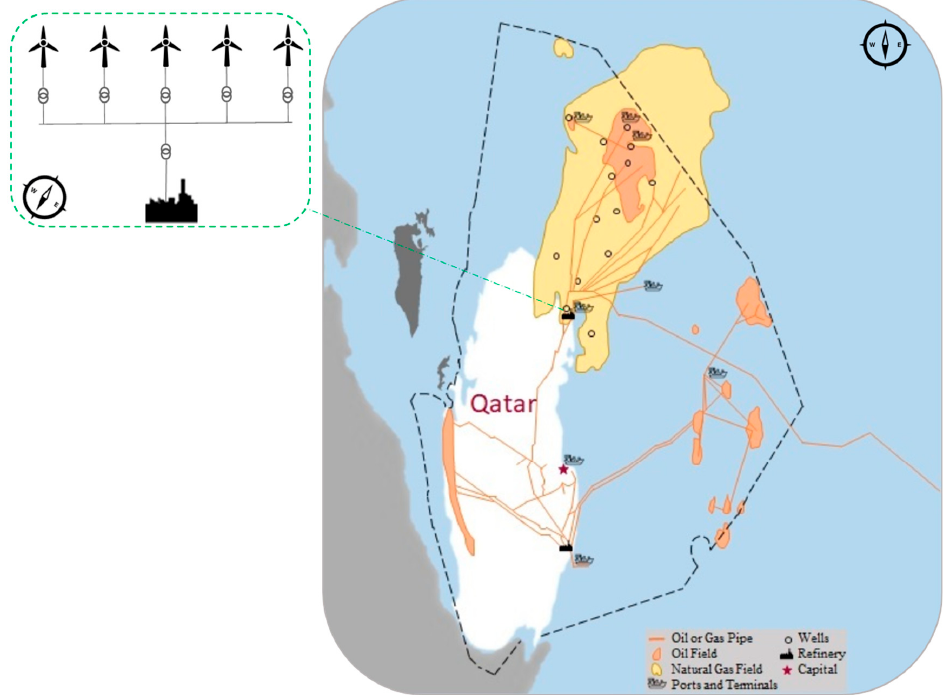
Figure 1. Map of Qatar with oil and gas fields, refinery, and the proposed wind farm.